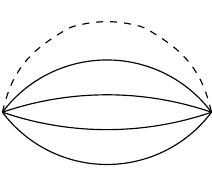
Figure 5 . The fundamental melon for q = 4. The dashed line represents the Wick contraction associated to the quenched